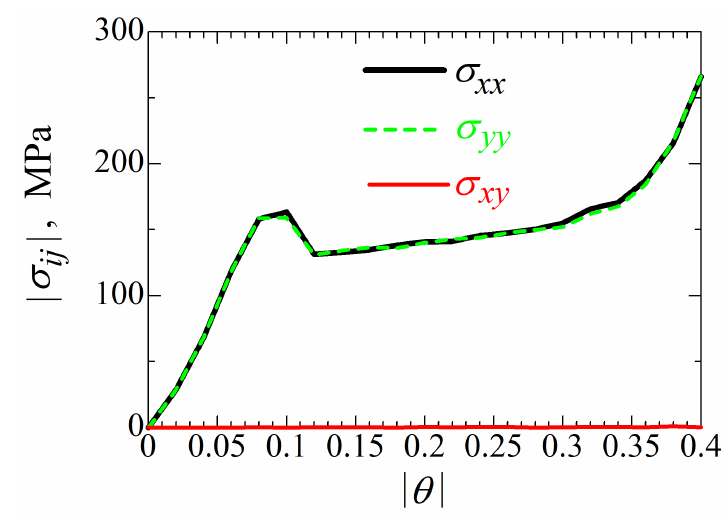
Figure 5. Stress components as the functions of the volumetric compressive